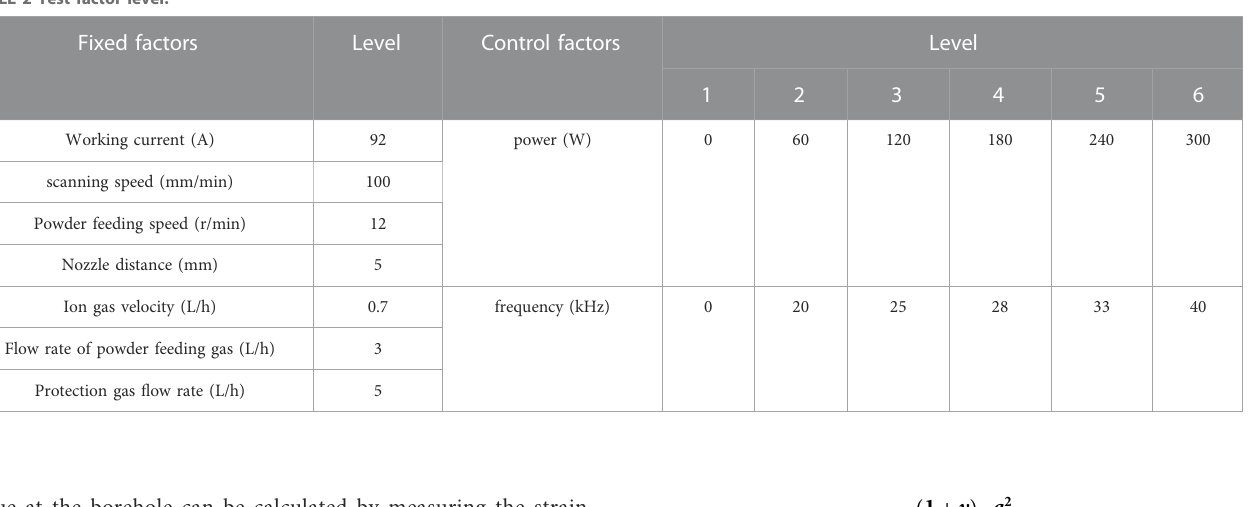
TABLE 2 Test factor